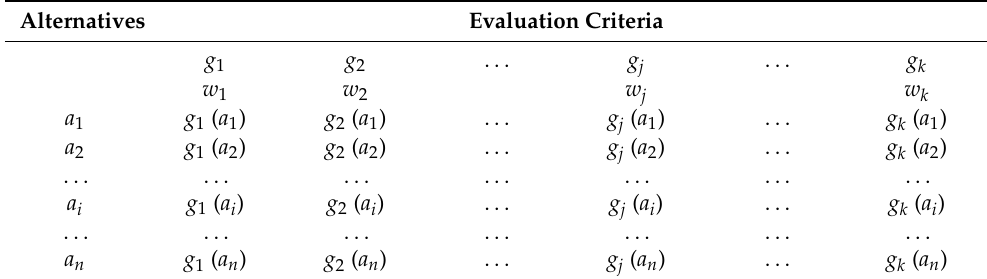
Table 1. Evaluation table. Alternatives Evaluation